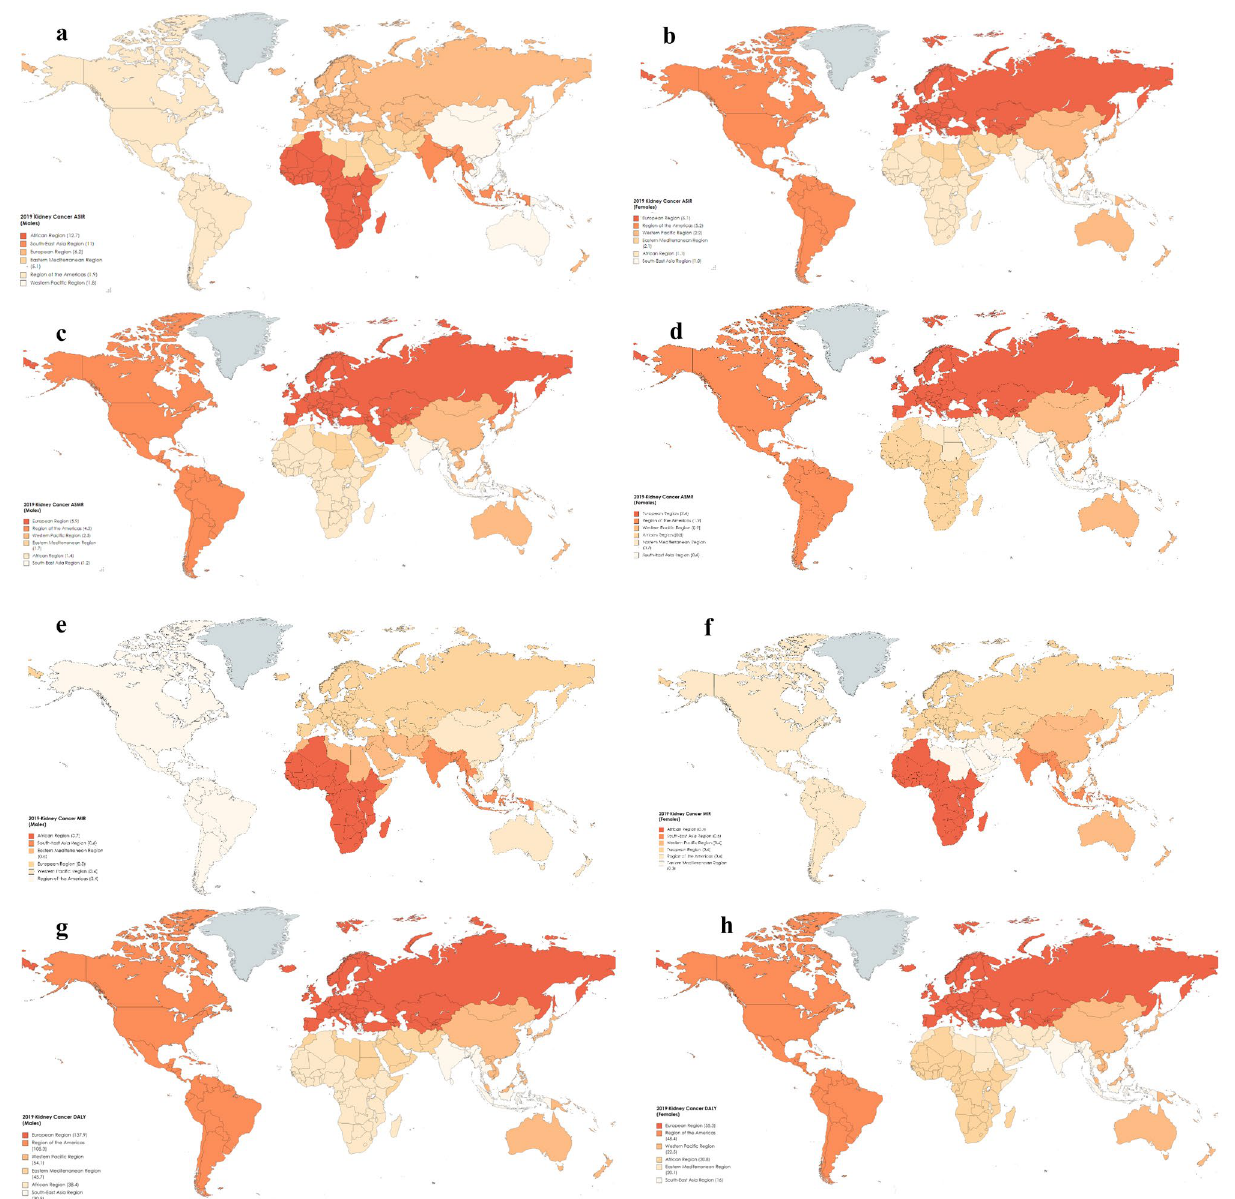
Figure 2. Age-standardized incidence rates (ASIR) for males ( a ) and females ( b ), age-standardized mortality rates for males (ASMR) ( c ) and females ( d ), mortality-to-incidence ratios (MIR) for males ( e ) and females ( f ) and disability-adjusted life years (DALYs) for males ( g ) and females ( h ) for kidney cancer (KC) for WHO regions in 2019. All indices are per 100,000 population. The figure is created by Dr. Chinmay Jani with mapchart.net (URL: https:// www. mapch art. net/) and is licensed under the Creative Commons Attribution- ShareAlike 4.0 International